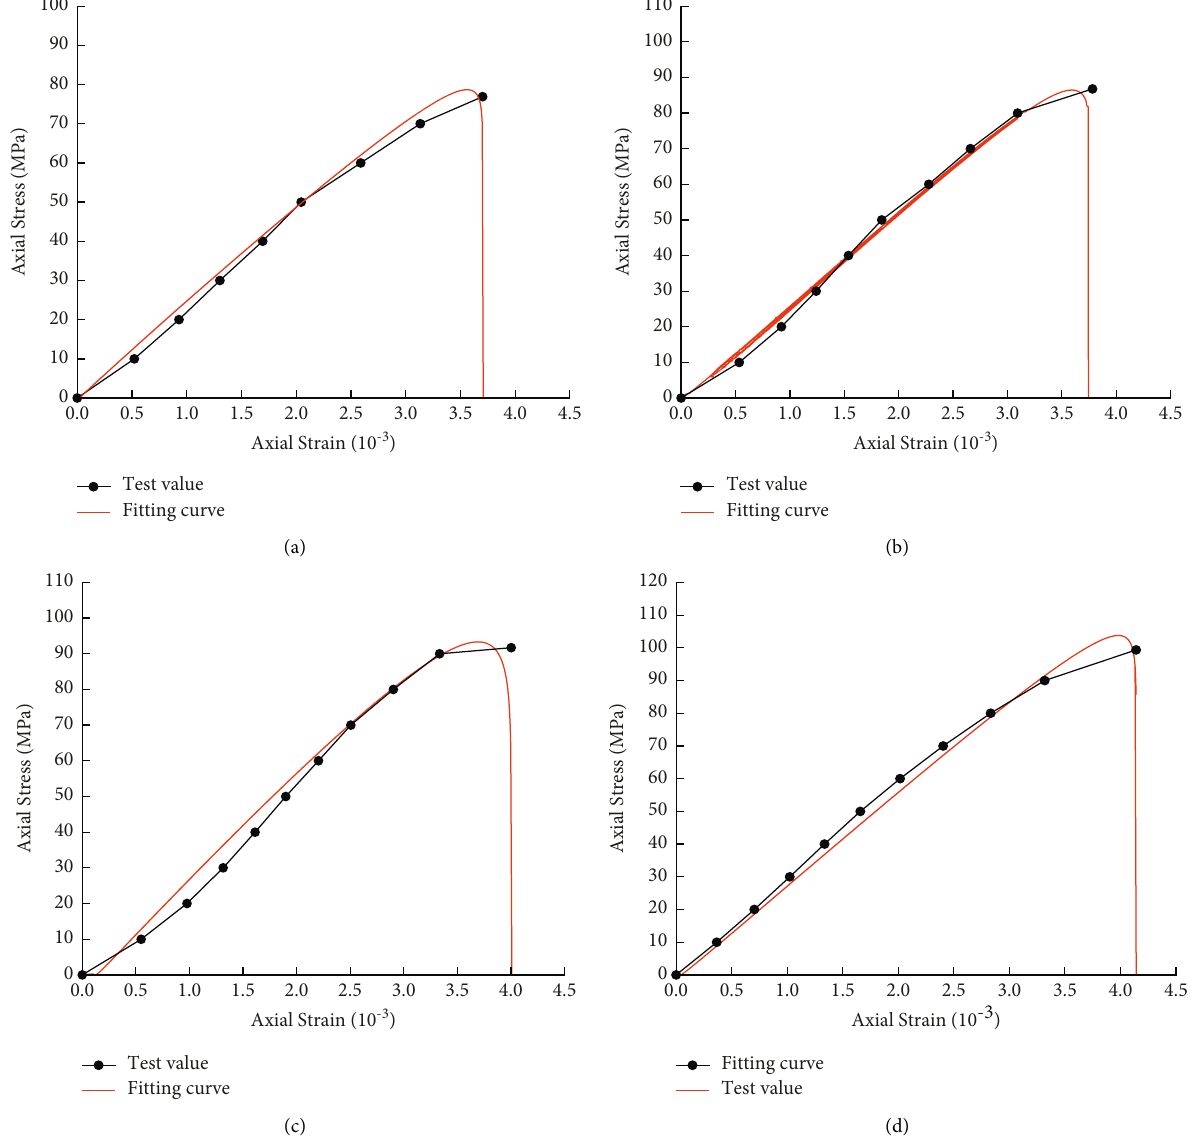
Figure 10: Axial stress-strain curves and theoretical curves under different confining pressures (10MPa, 15 MPa, 20MPa, and